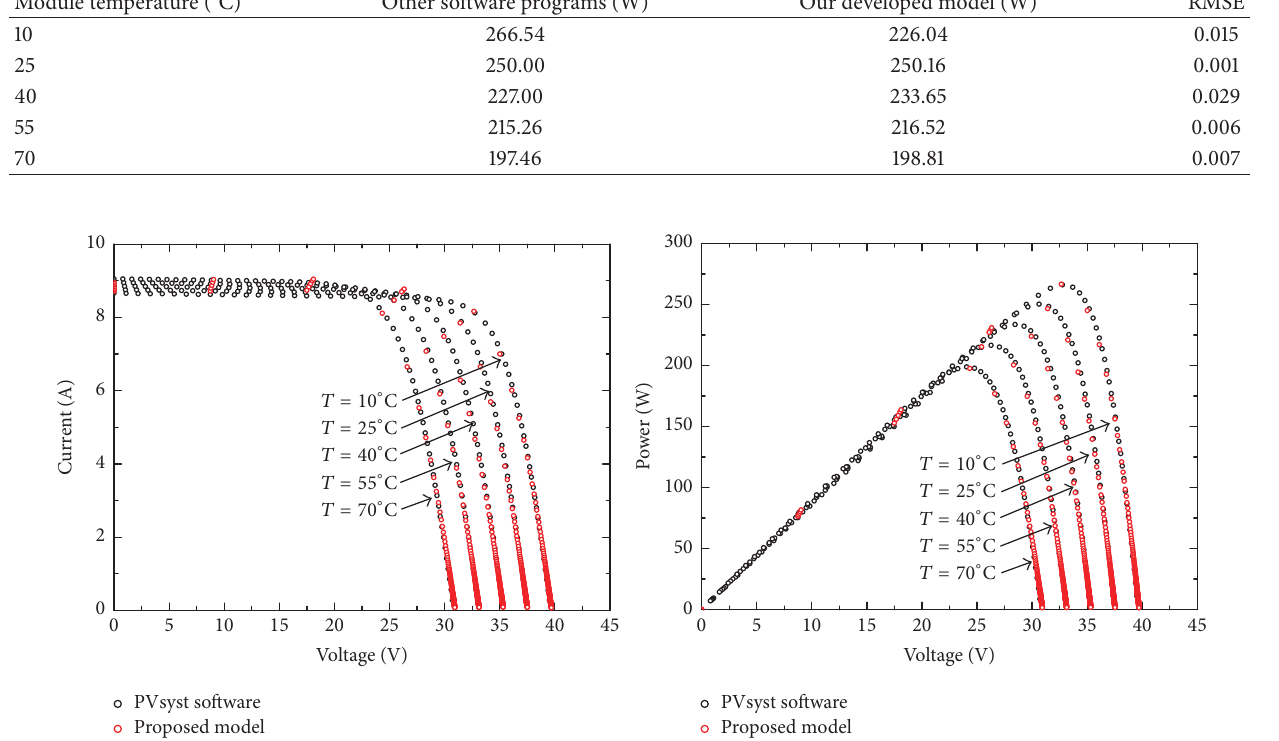
Figure 6: PV module’s 𝐼 - 𝑉 curves and 𝑃 - 𝑉 curves under different module temperature (solar irradiance = 1000W/m 2 ).